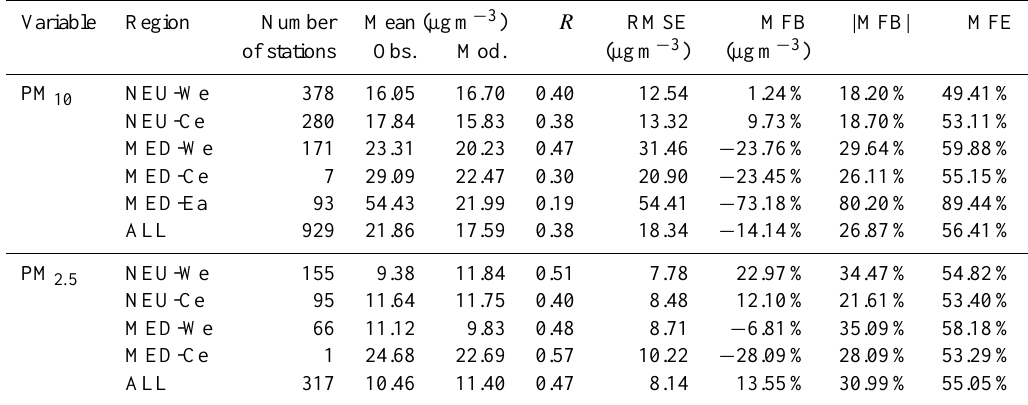
Table 2. Performance statistics for the simulation of hourly PM with CHIMERE (Mod.) compared to coincident surface station measurements (Obs.) during the summer of